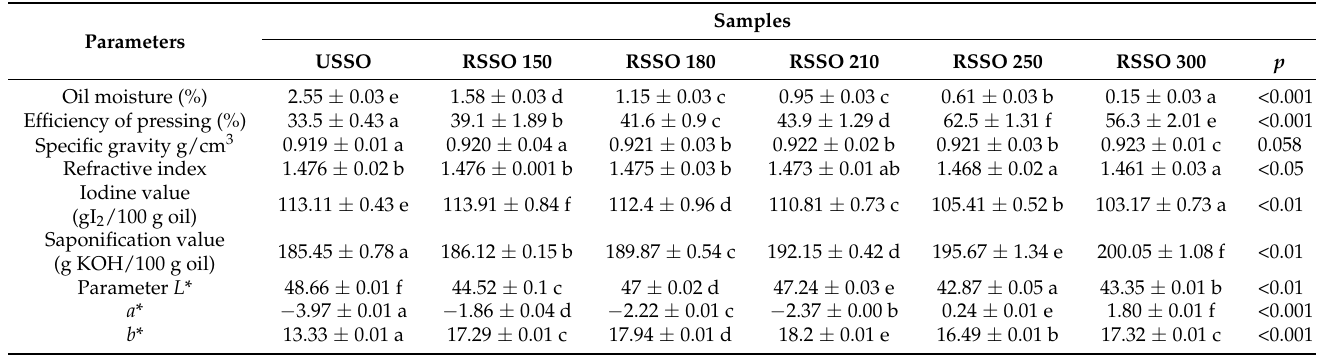
Table 1. Physical and chemical parameters of unroasted and roasted sesame oils.